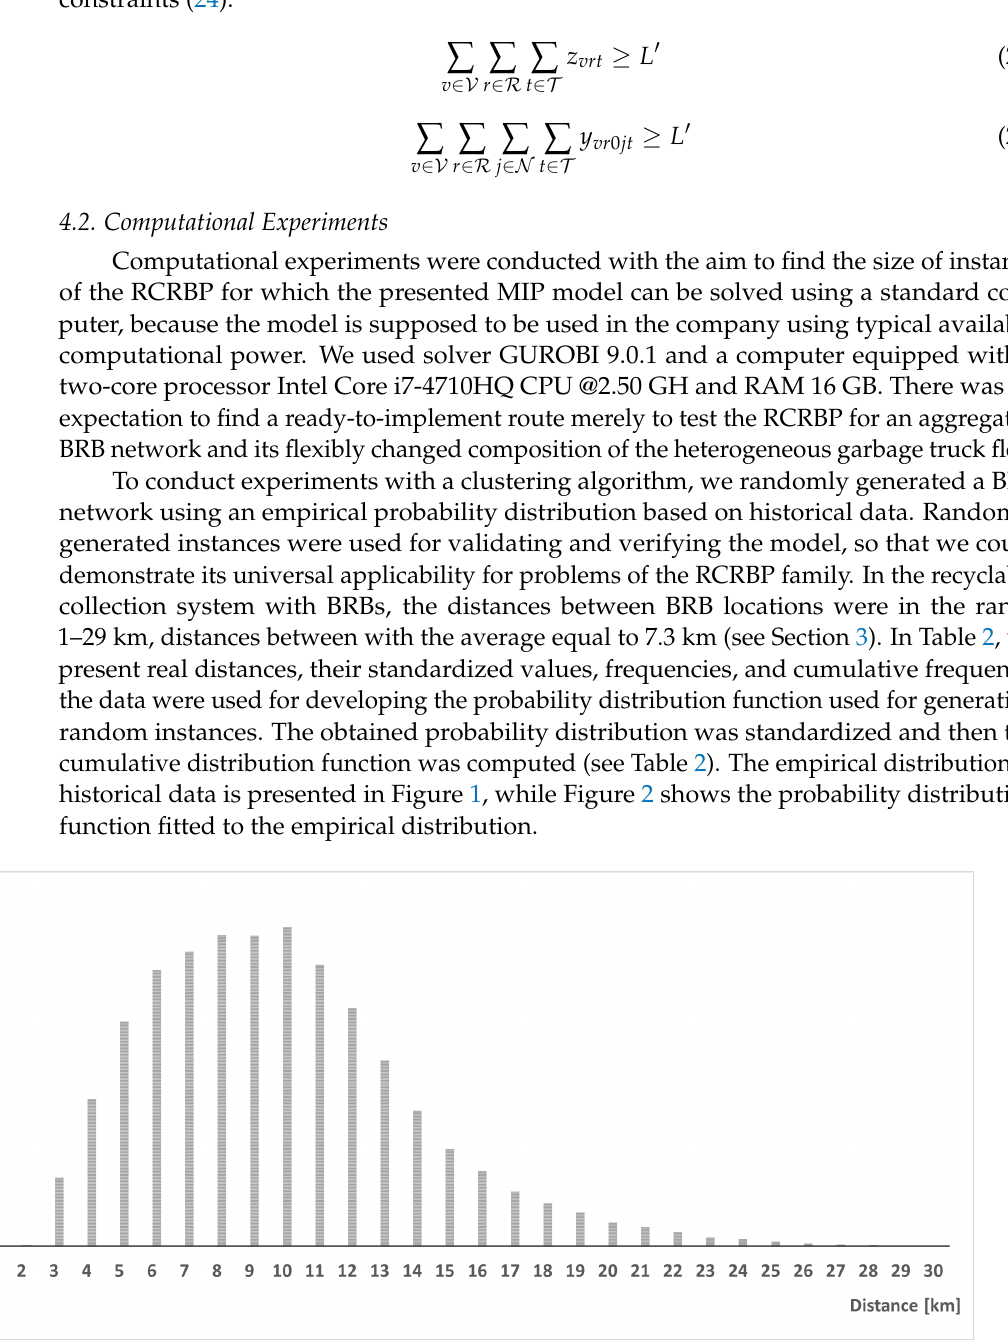
Figure 1. Empirical distribution of the distance between BRB locations—historical